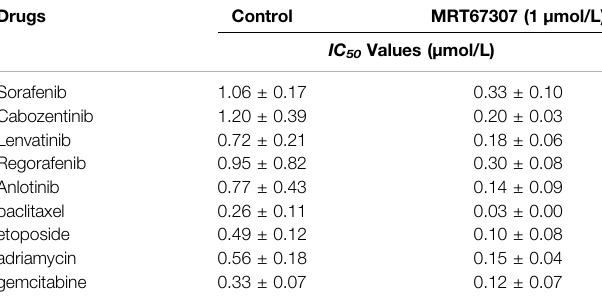
TABLE 8| TheeffectofMRT67307 (1 μ mol/L)ontheantitumor effect ofantitumor drugs in MHCC97-H cells. Drugs